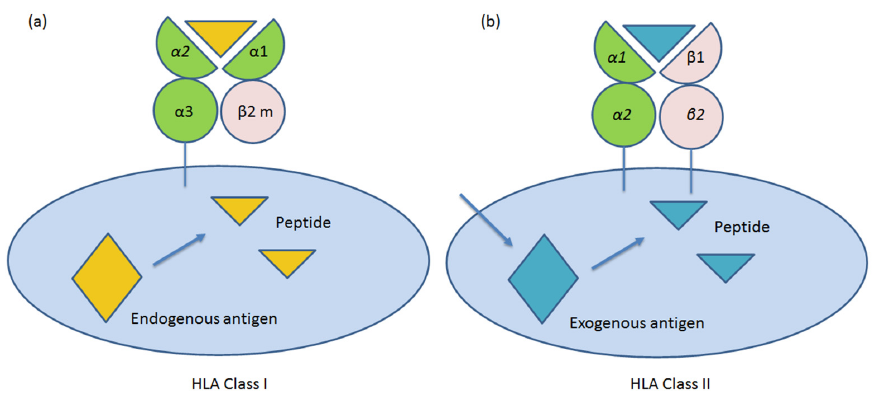
Figure 2. Schematic representation of molecular structure of human leukocyte antigen (HLA) class I ( a ) and II ( b ) molecules in human cells. β 2 m: β 2 microglobulin. HLA class II molecules are expressed constitutively on professional antigen-presenting cells (APC), such as dendritic cells, mononuclear phagocytes and B cells. The antigens presented by class II peptides are of extracellular origin and are loaded onto HLA class II molecules by phagocytosis. These antigens stimulate the proliferation of T-helper cells, which in turn elicit B-cells to secrete antigen-specific antibodies [9]. In particular, activation of T cells requires two signals, a first signal, which is antigen-specific, is provided through the T cell receptor (TCR) which interacts with peptide- HLA class II molecules on the membrane of APC. A second signal, the co-stimulatory signal, is antigen nonspecific and is provided by the interaction between co-stimulatory molecules expressed on the membrane of APC (i.e., CD80 and CD86) and the T cell (i.e., CD28). In human pregnancy, tight control of human leukocyte antigens (HLA) class I and II expression